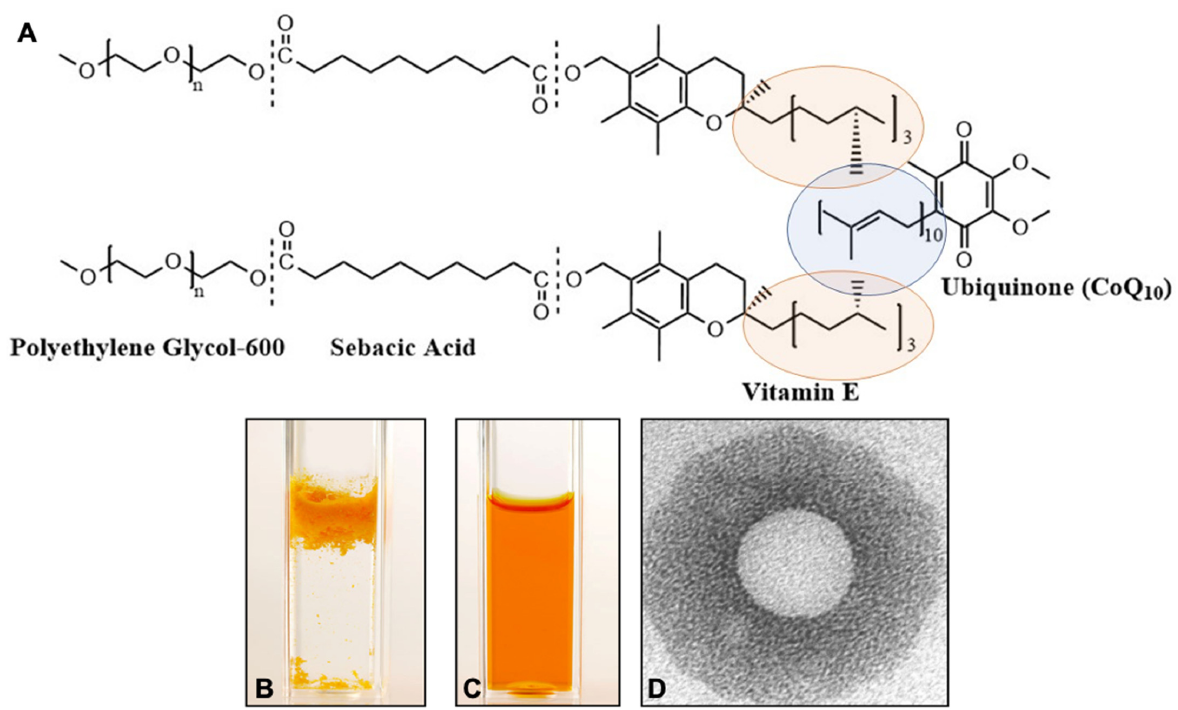
Figure 1. Ubisol-Q 10 formulation. ( A ) chemical composition of the formulation consisting of 2 molecules of PTS per 1 molecule of CoQ 10 ; ( B ) a direct suspension of 100 mg CoQ 10 in water; ( C ) the same quantities of CoQ 10 formulated with PTS as Ubisol-Q 10 (clear and transparent solution of Ubisol-Q 10 stable for years); ( D ) Transmission electron micrograph of a single Ubisol-Q 10 nanomicelle measuring on average 22 ± 7 nm in diameter.